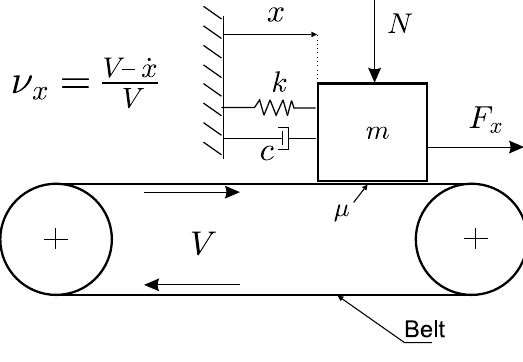
Fig. 2. Single d.o.f. oscillator excited by